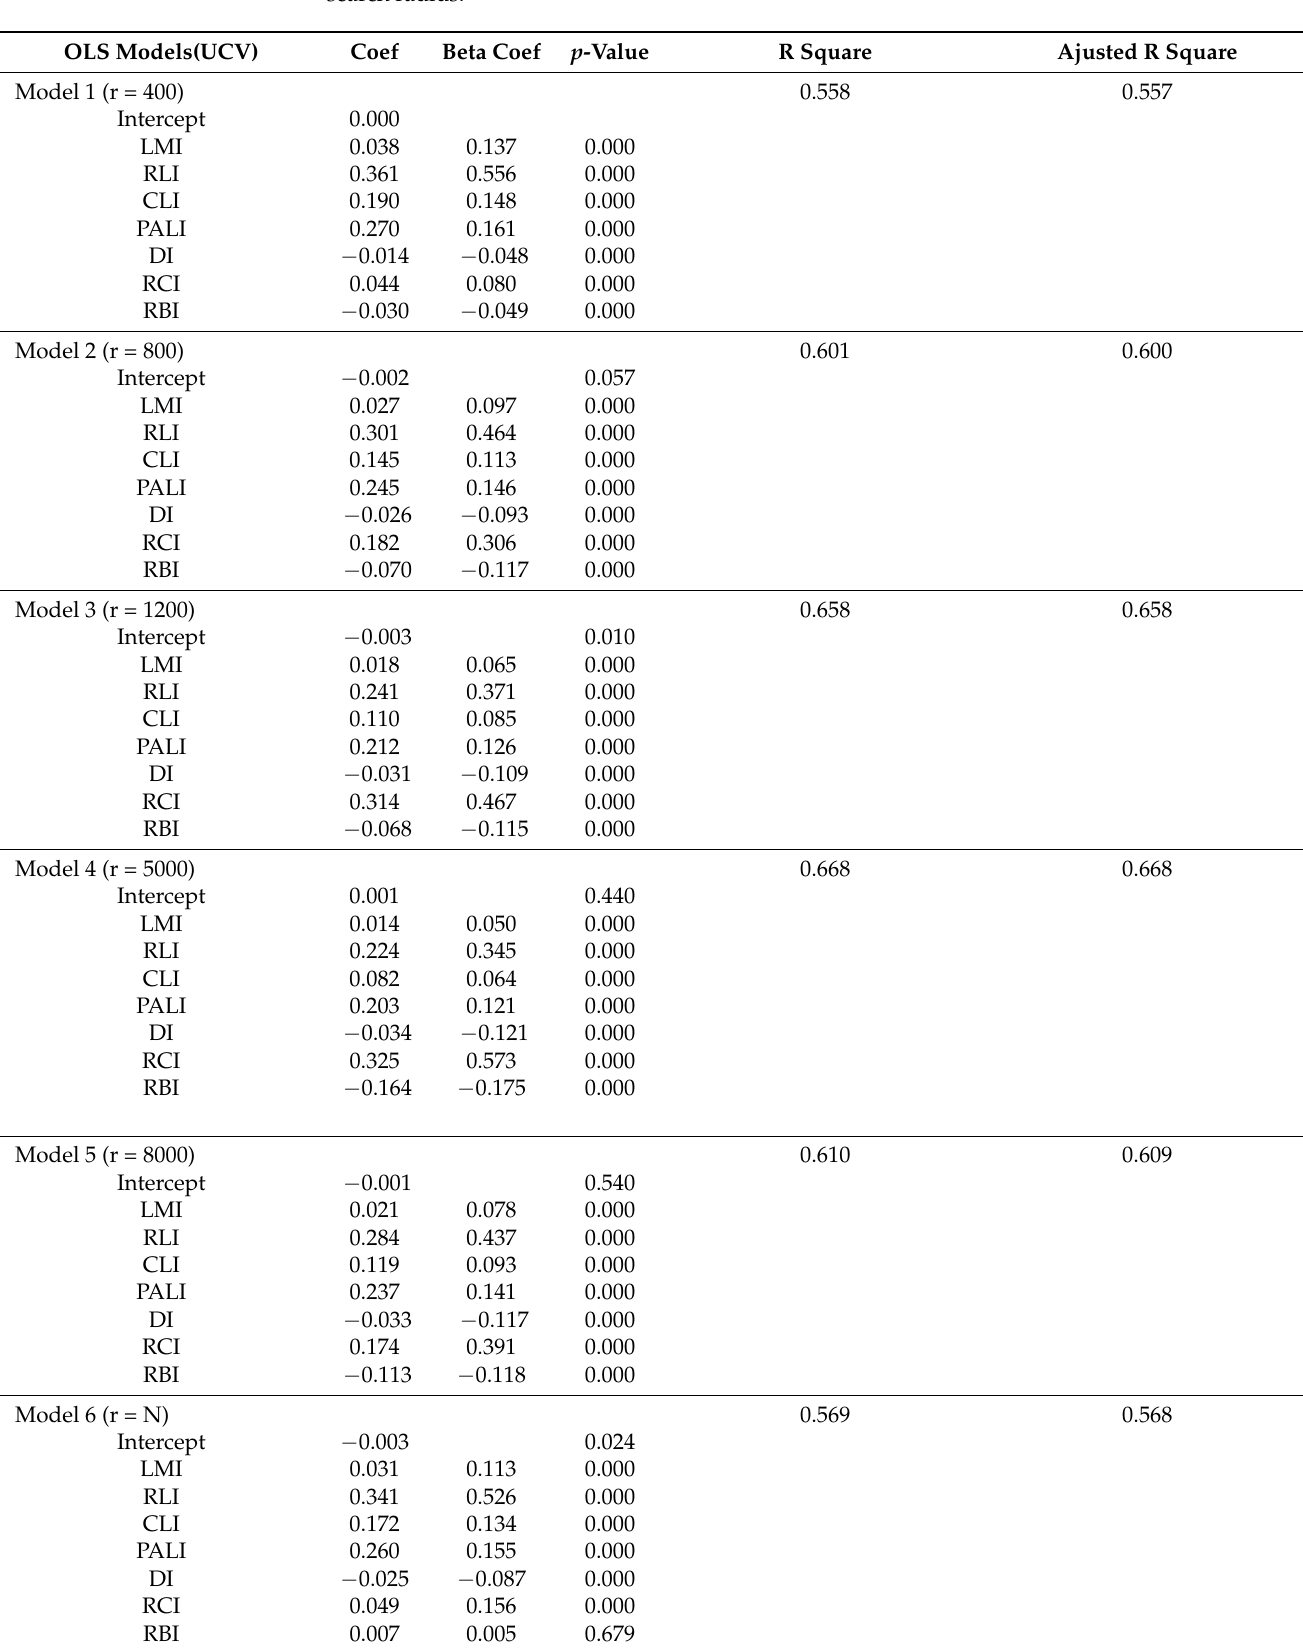
Table A4. The resulting for ols model between UCV and built environment variables under different search